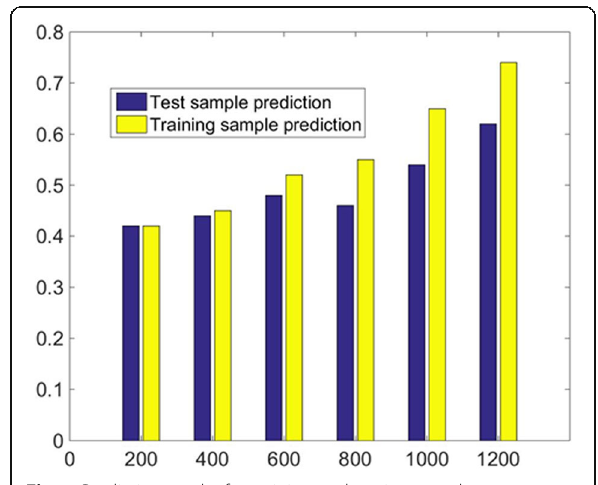
Fig. 5 Prediction results for training and testing